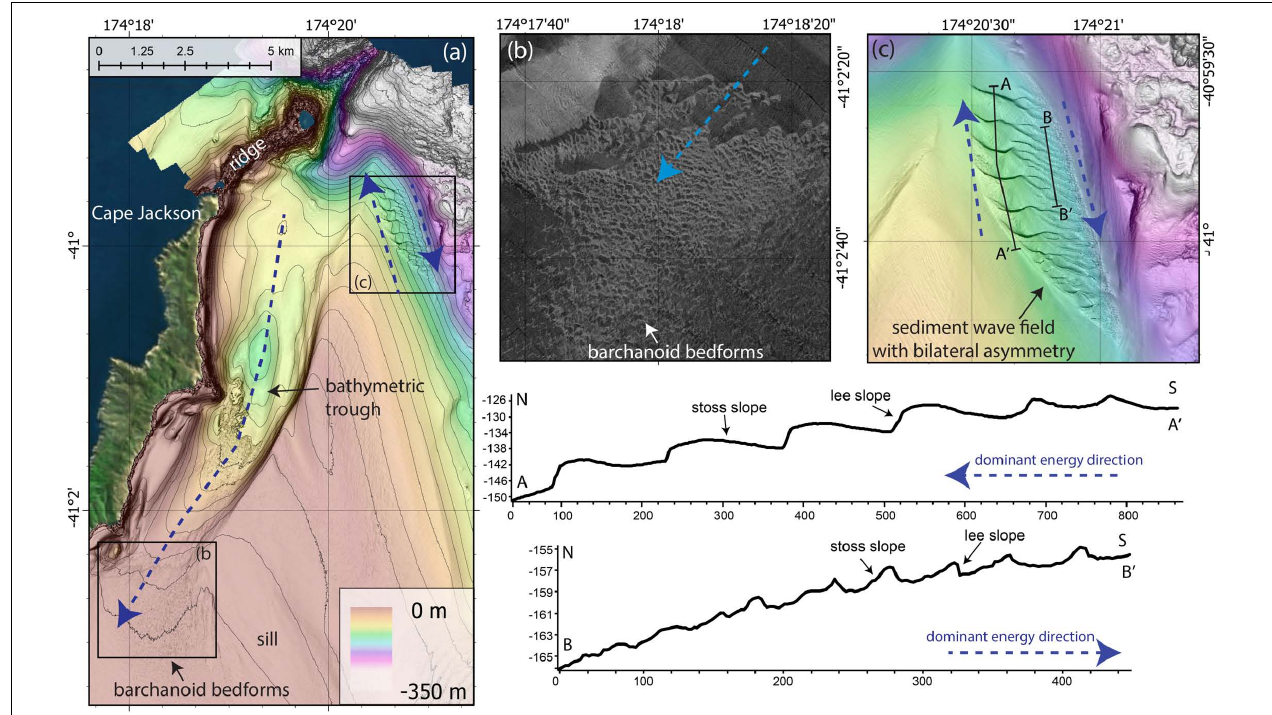
FIGURE 7 | (a) Detailed view of the bathymetric trough that runs adjacent to the Cape Jackson coastline. Black squares show locations of insets b & c. black lines are bathymetric 10 m contours. Navy blue arrows show dominant transport direction as interpreted from seafloor geomorphology. (b) seafloor backscatter signature of barchanoid mega-ripples at the southern end of the Cape Jackson trough, showing strong alternating highs (peaks) and lows (troughs) intensity seafloor backscatter. (c) Sedimentary waves east of Cape Jackson displaying bilateral asymmetry, where the bedforms on the western side of the wave field indicate northward transport, and the bedforms ∼ 600 m to the east in the same wave field indicate southward transport. Locations of Profiles A-A’ and B-B’ are shown. Profiles A-A’ and B-B’ show differences in the size and transport direction of